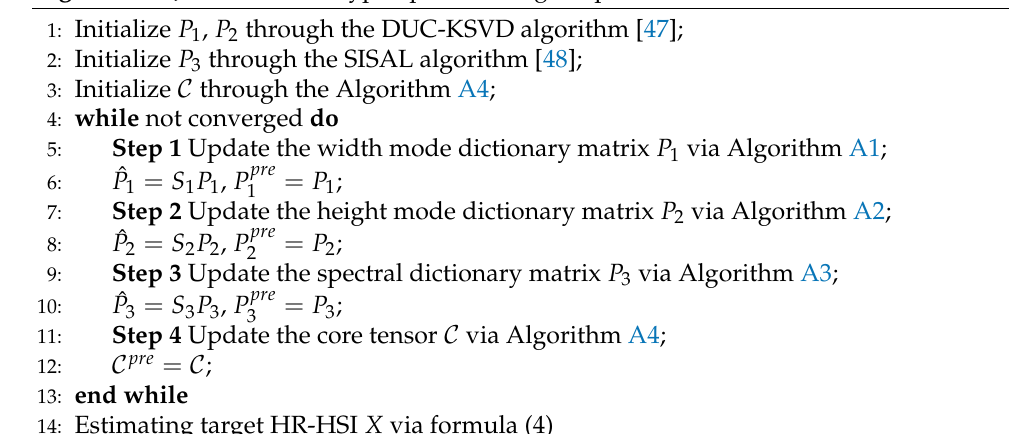
Algorithm 1 specifies the steps of the JRLTD-based hyperspectral image super-resolution proposed in this section. Algorithm 1 JRLTD-Based Hyperspectral Image